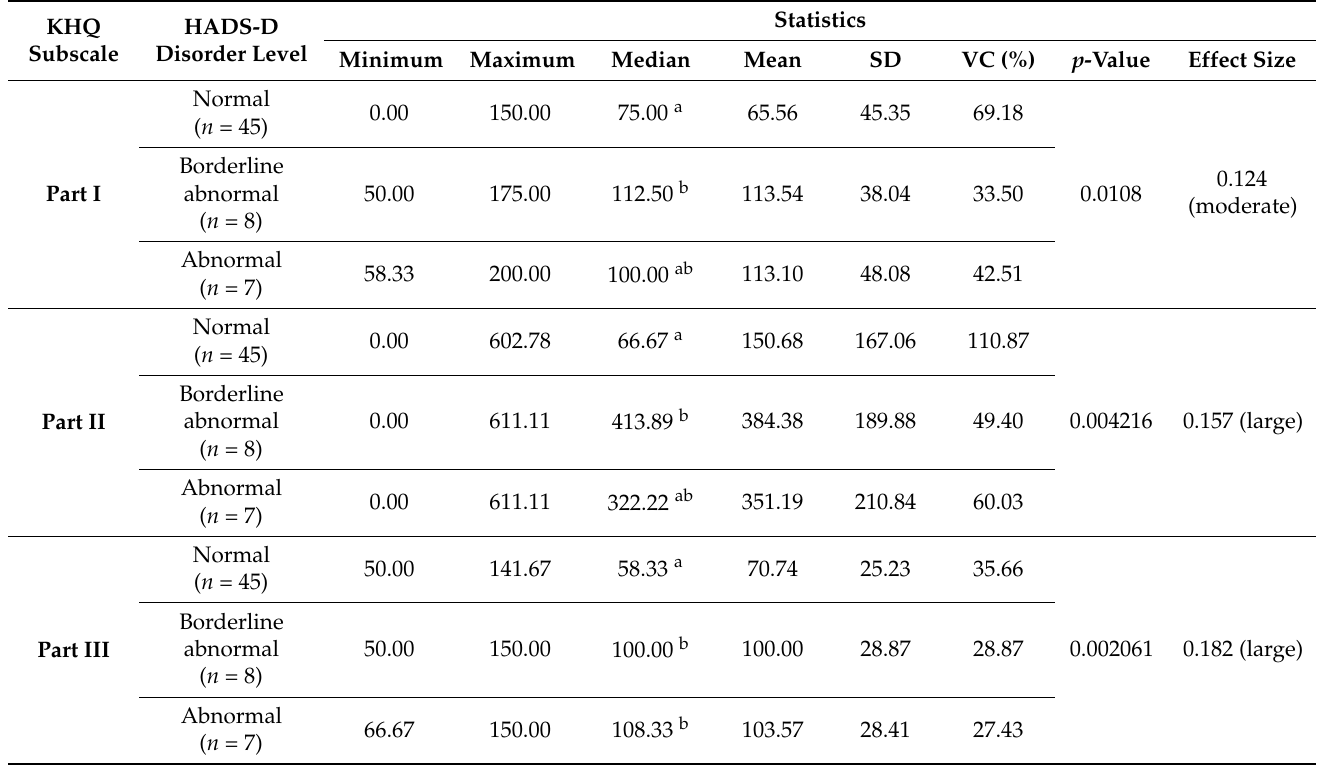
Table 7. KHQ—Parts I, II, III sub-scale scores for women 12 months after the surgery, with different disorder stages defined based on the HADS-D